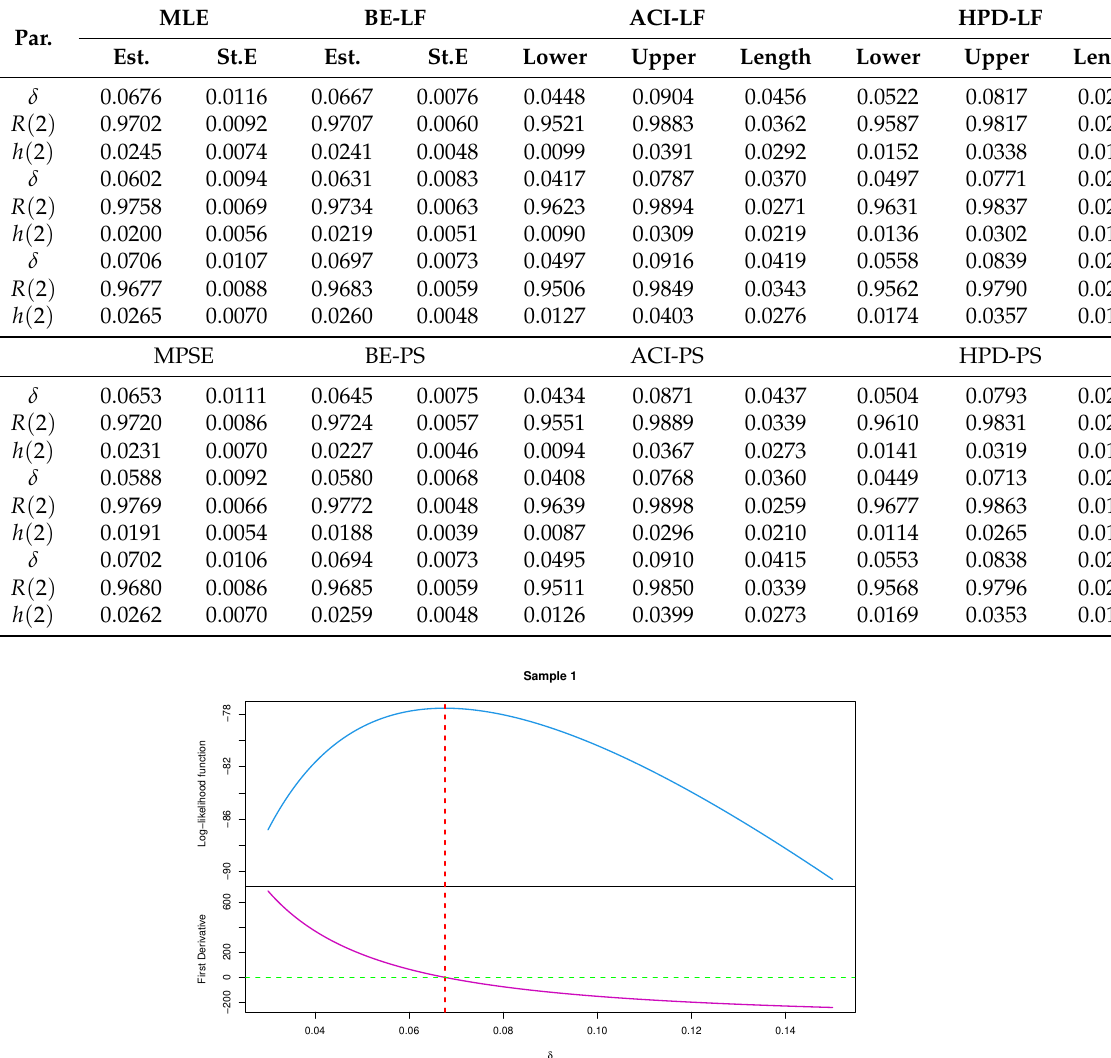
Figure 10. The log-likelihood function and the associated first derivative of δ from MVAD data.